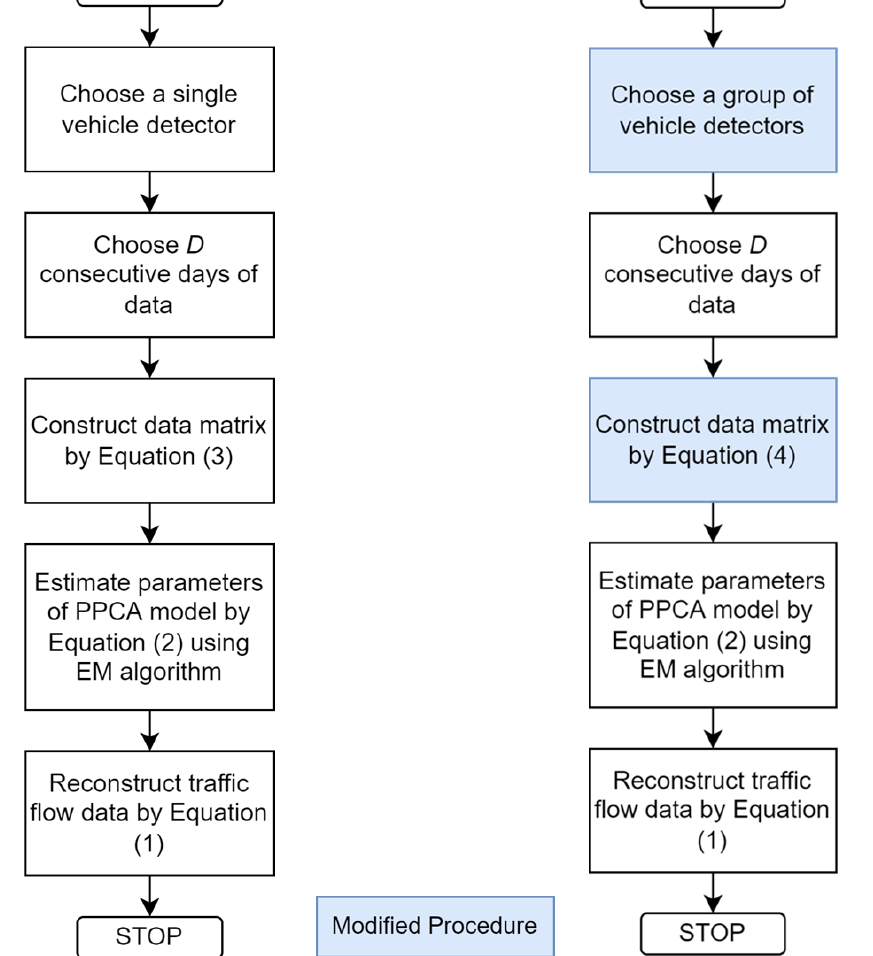
Figure 2. Single detector ( left ) and spatiotemporal ( right ) PPCA-based data imputation method flowchart comparison. EM algorithm for the estimation of PPCA model parameters was formulated in references [34,36,37].